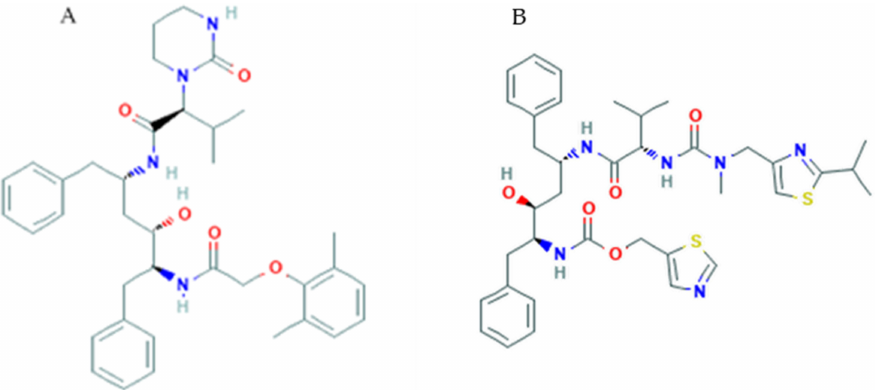
Figure 8. Chemical structure of lopinavir ( A ) and ritonavir ( B